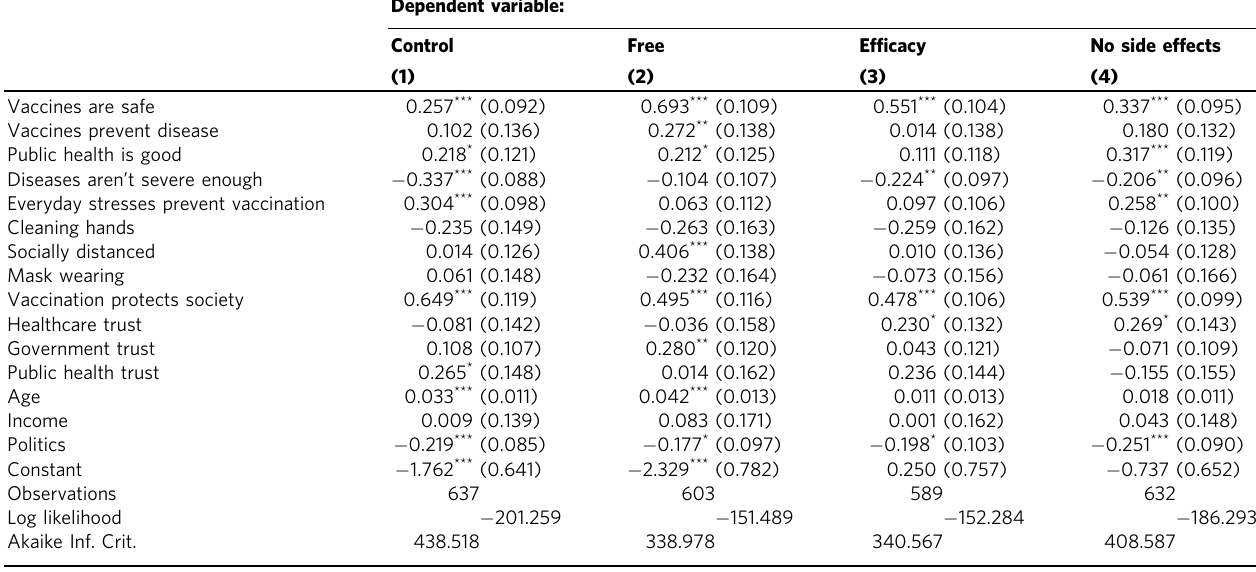
Table 3 Classi fi cation model of all participants into hesitants and acceptants.